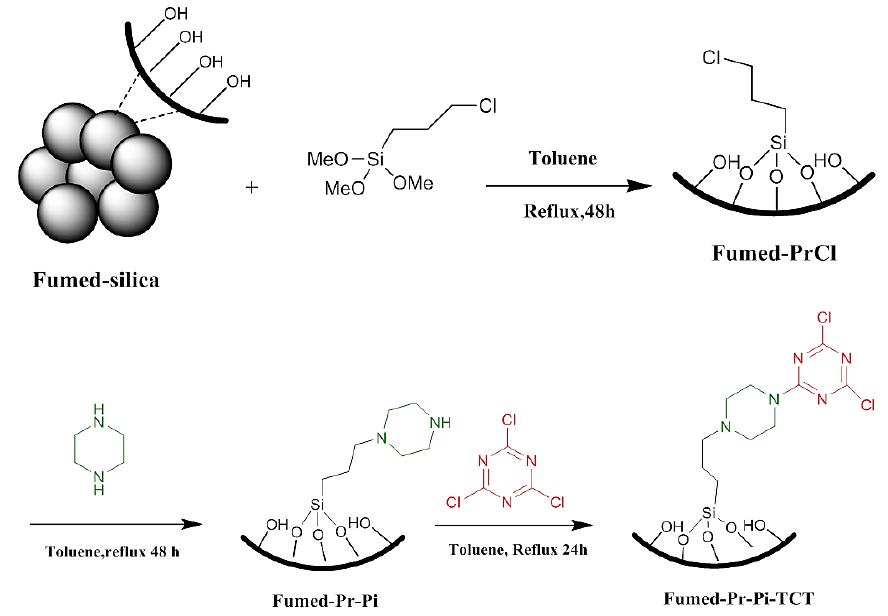
Figure 1. According to the FT-IR spectrum, the organic moieties bonded on the silica fume were proven. The two peaks at 1100 and 800 cm ⁻ ¹ depend on the asymmetric stretching vibrations of Si-O-Si groups. The band was about 3420 cm ⁻ ¹ and can also be considered to be related to the stretching O-H of Si-OH functional groups on the surface. The absorbance bands at 3431 and 1101 cm ⁻ ¹ fit the stretching and bending of N-H in fumed-Pr-Pi, respec- tively [45]. Finally, the peak at 1700 cm ⁻ ¹ is related to the C=N groups, and the peaks at 1560 to 1400 cm ⁻ ¹ are also related to the aromatic groups in the